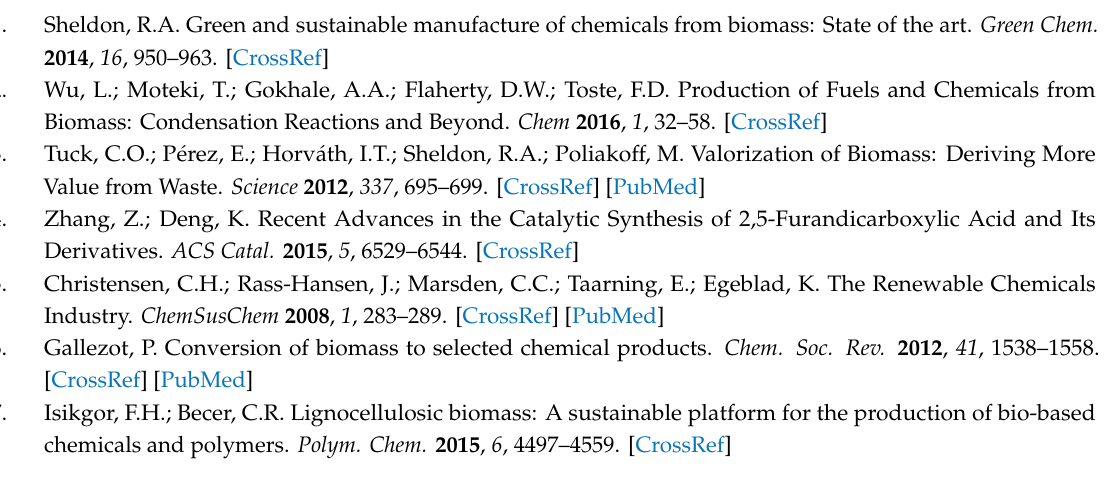
Figure S1: HPLC measurements: ( A ) HMF and its derivatives; ( B ) HMF substrate, HMFCA and BHMF products. Figure S2: E ff ects of reaction time on HMFCA synthesis. Figure S3: Biocatalytic oxidation of HMF to HMFCA by di ff erent Deinococcus strains. Figure S4: E ff ect of cell concentration on HMFCA synthesis. Figure S5: Optimizing reaction condition for HMFCA synthesis by using various